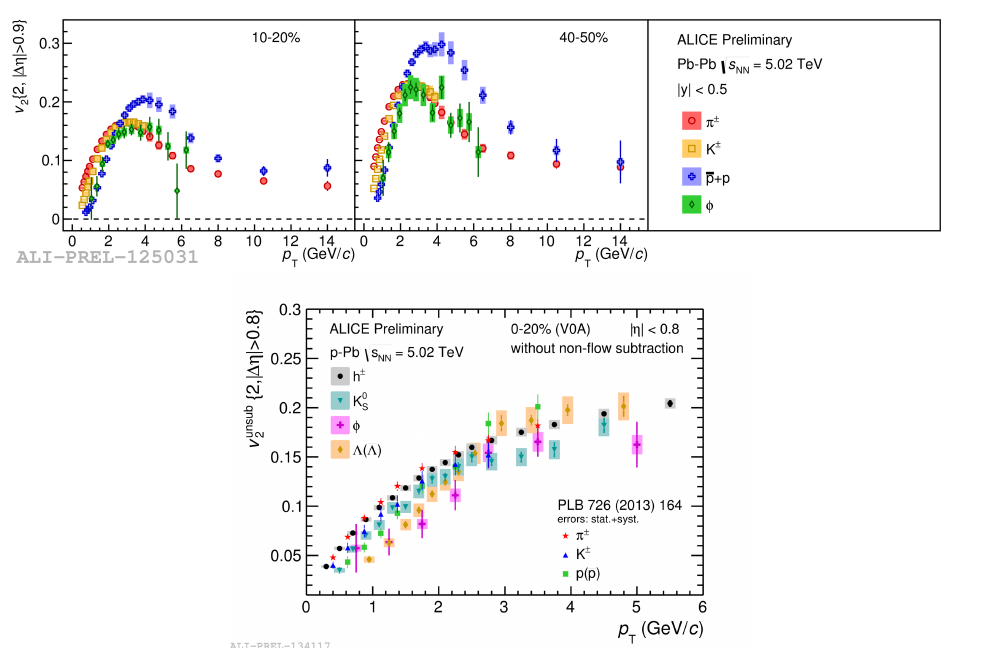
Figure 12. Top figures : elliptic flow v 2 in PbPb collisions as a function of p T in two centrality classes and four particle species [28]; Bottom figure : Elliptic flow v 2 in pPb collisions